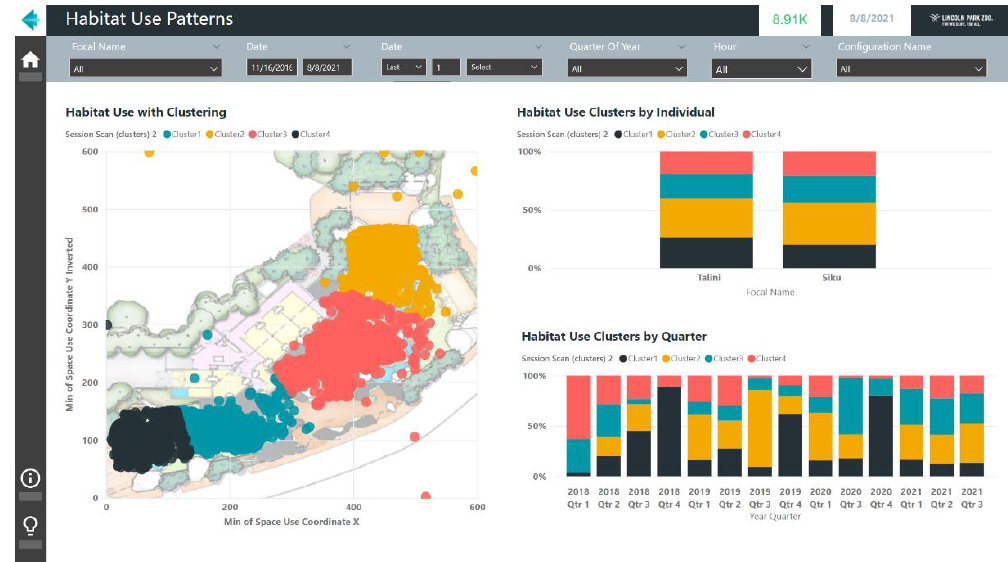
Figure 4. An example screenshot of a report showing habitat use data for two polar bears clustered using built-in algorithms in the Power BI software.